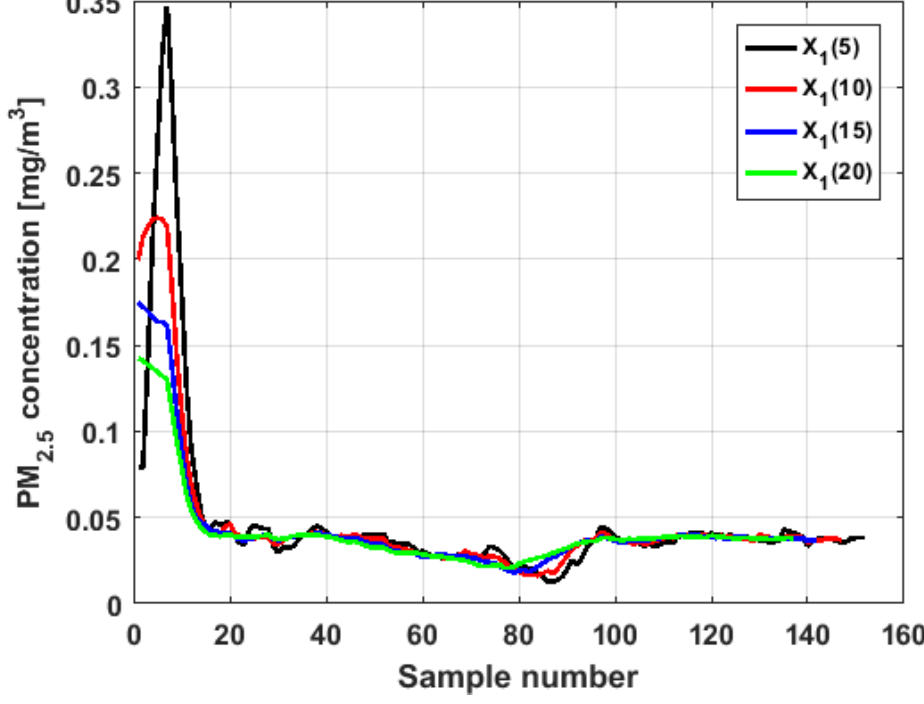
Figure 7. Moving average (MA) of 𝑋 1 for different sizes.